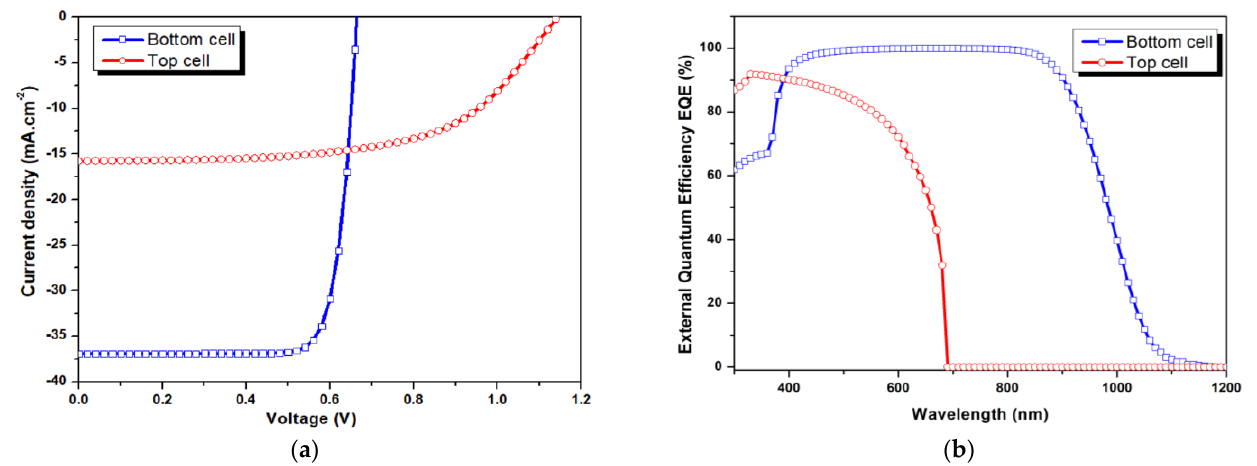
Figure 4. ( a ) J – V curve of silicon bottom sub-cell and perovskite top sub-cell ( b ); external quantum efficiency (EQE) of the two sub-cells in standalone conditions.